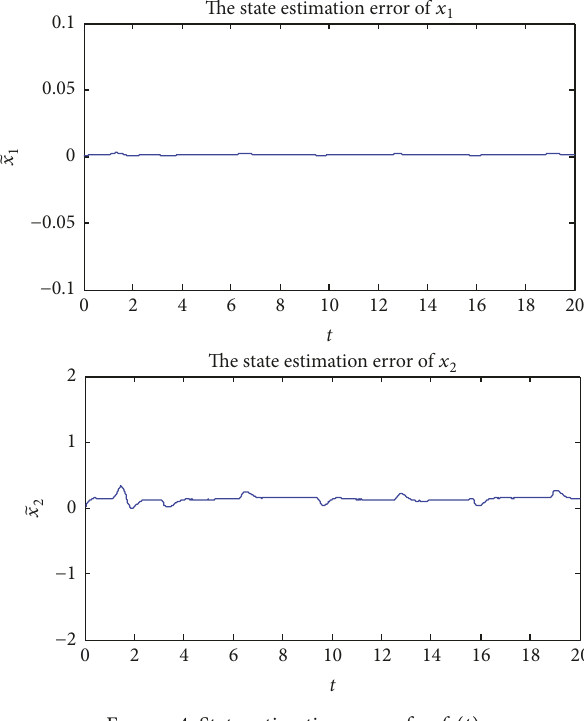
Figure 4: State estimation errors for 𝑓 2 (𝑡) .